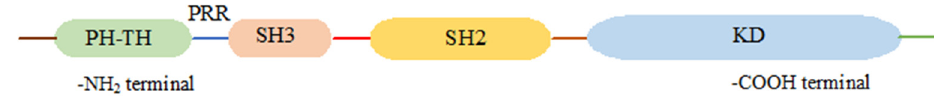
Figure 1. 2D representation of domain arrangement in the whole BTK.